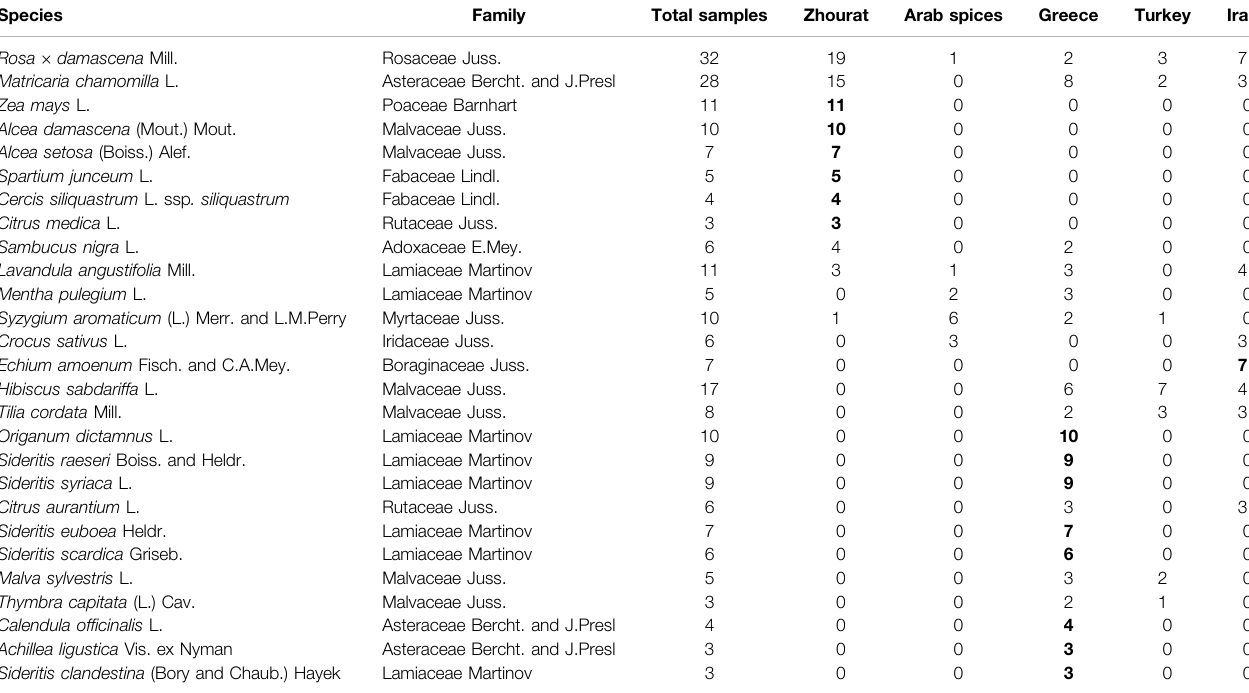
Bold character mark relevant numbers. Species included are only those found in three or more